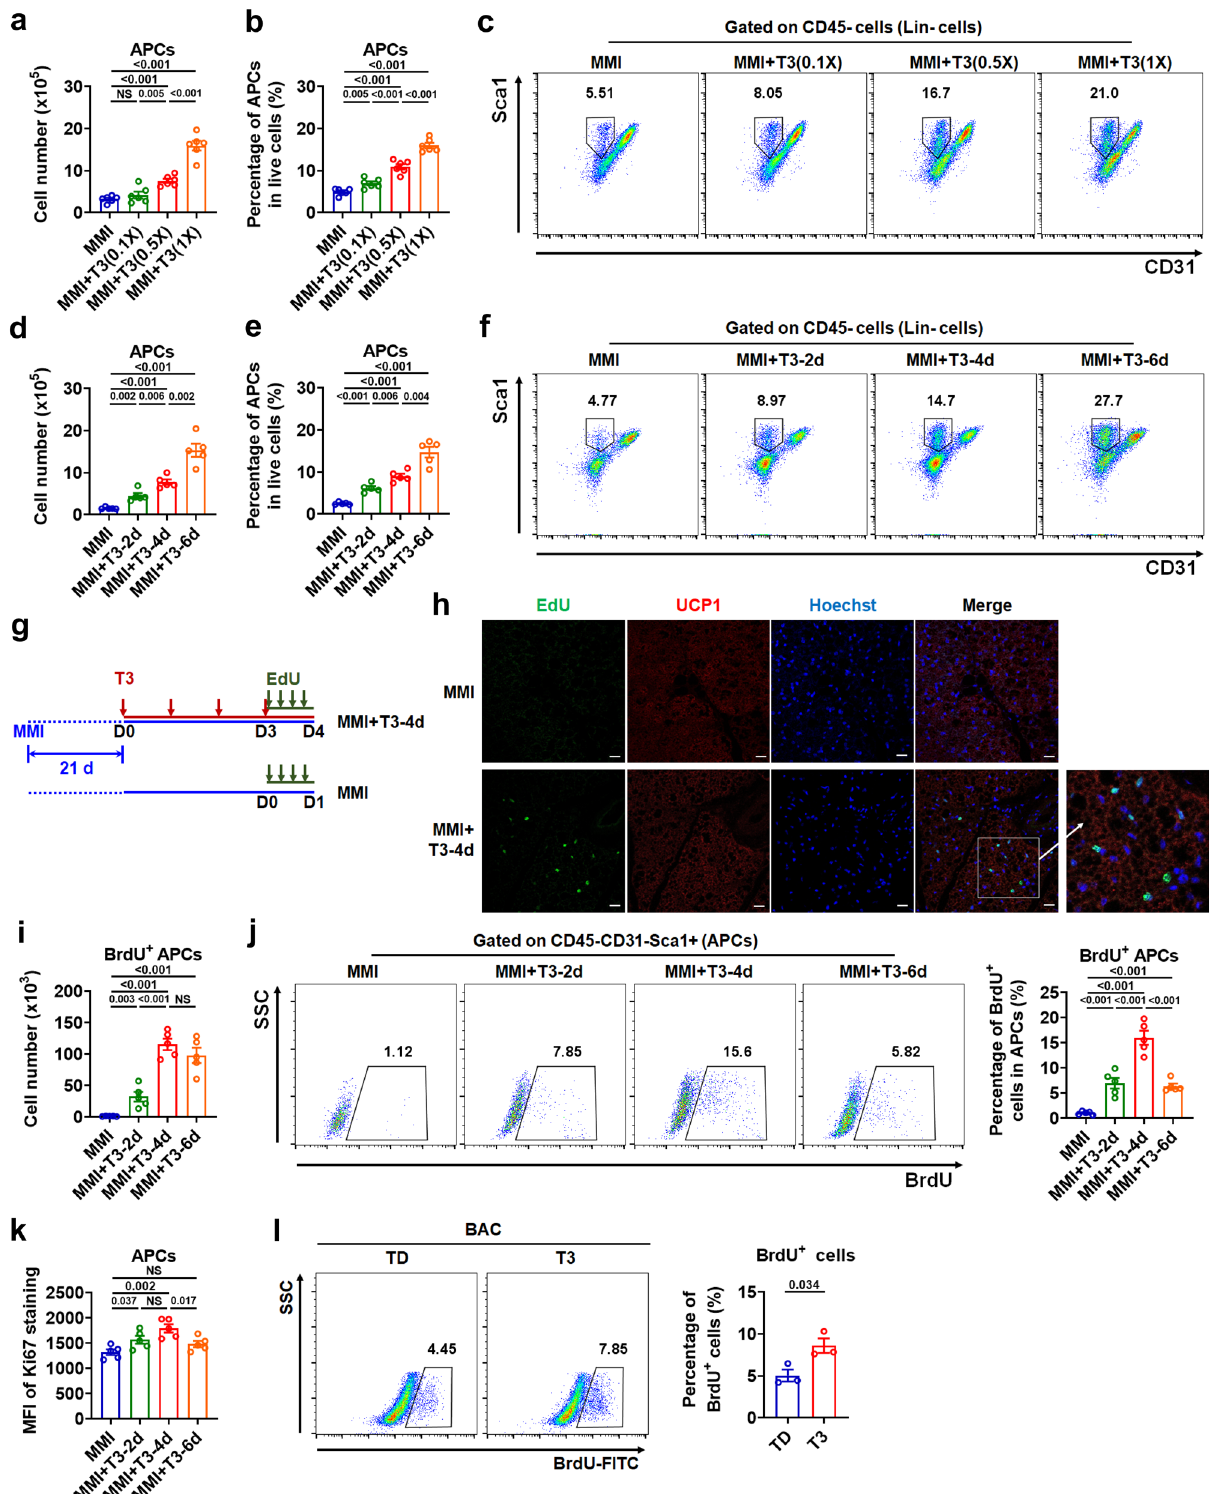
newly generated cells in the iBAT of MMI mice after T3 treatment (Fig. 2g). Fluorescence microscopy analysis revealed that EdU + cells could be observed after T3 treatment but barely detectable in the iBAT of MMI mice without T3 treatment (Fig. 2h). Analysis of in vivo BrdU labeling by fl ow cytometry revealed a gradual increase in both the number and the percentage of BrdU + APCs after daily T3 injections in MMI